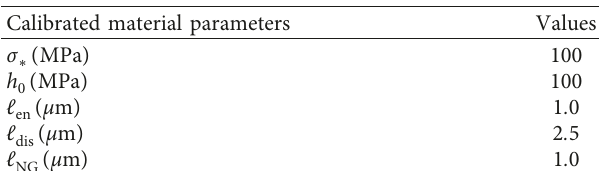
Table 2: Calibrated material parameters of aluminium for the current numerical simulations.